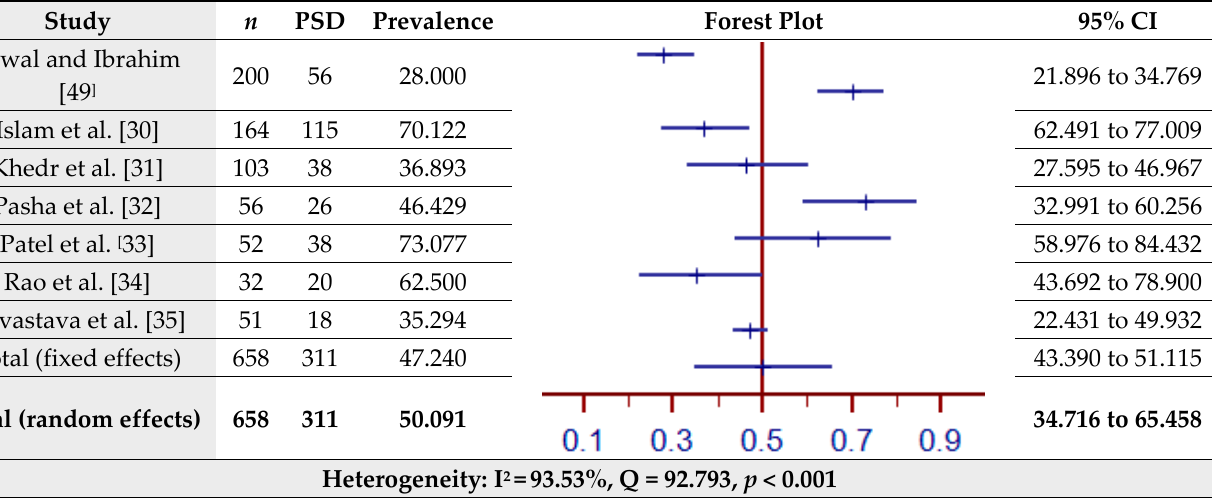
Figure 3. Prevalence estimates of Post-Stroke Depression (PSD) assessed by the Hamilton Depression Rating Scale (HDRS).